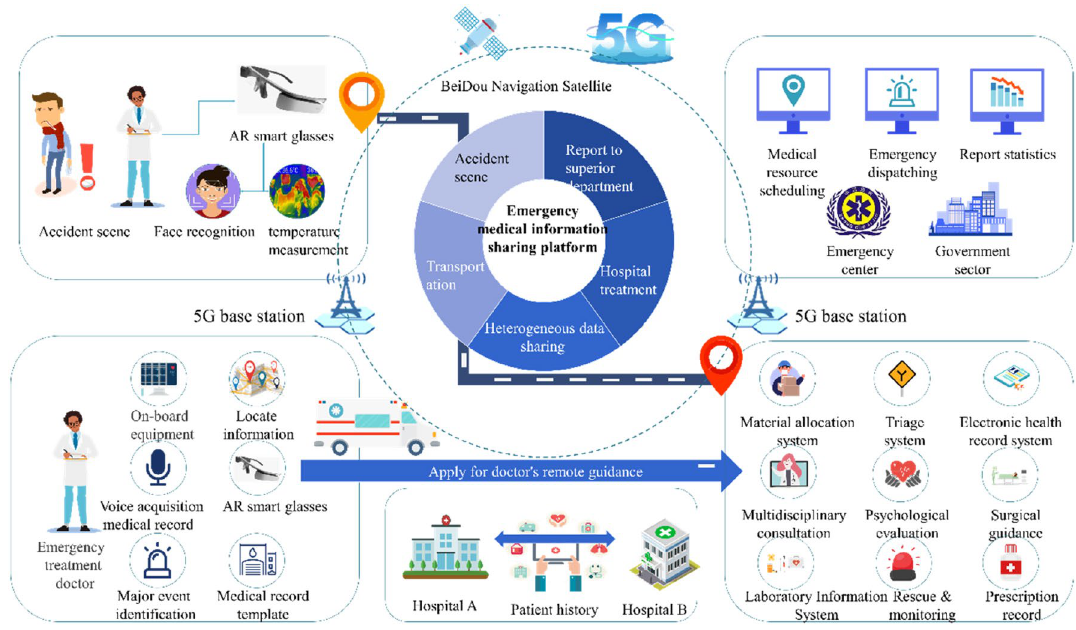
Figure 1. The 5G-enabled smart ambulance proposed